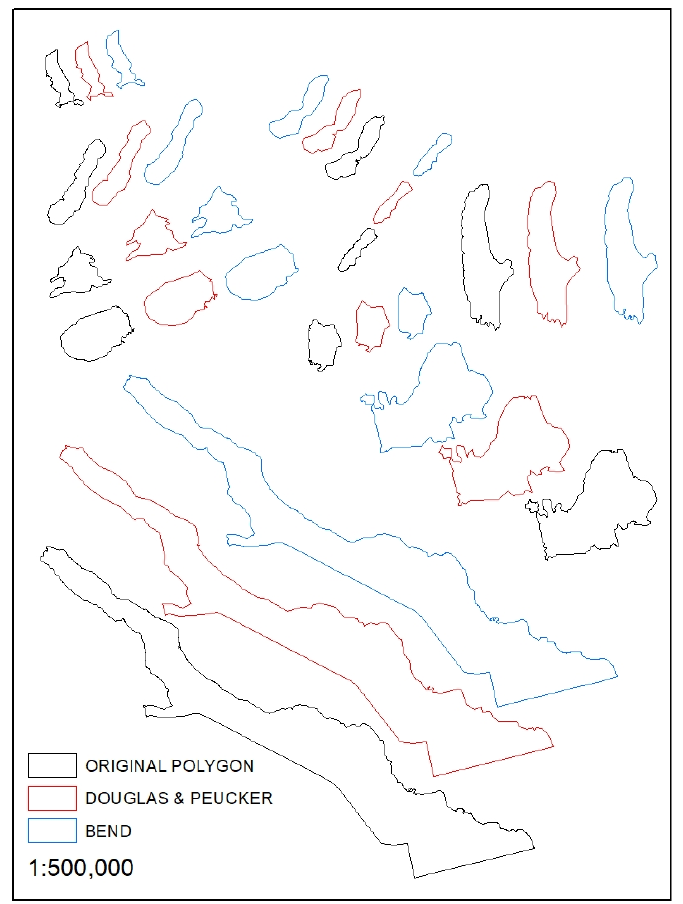
Figure 7. Polygon features simplified with the Douglas–Peucker simplification algorithm (red) and bend simplification algorithm (blue). Original polygons are depicted in black (scale 1: 500,000).